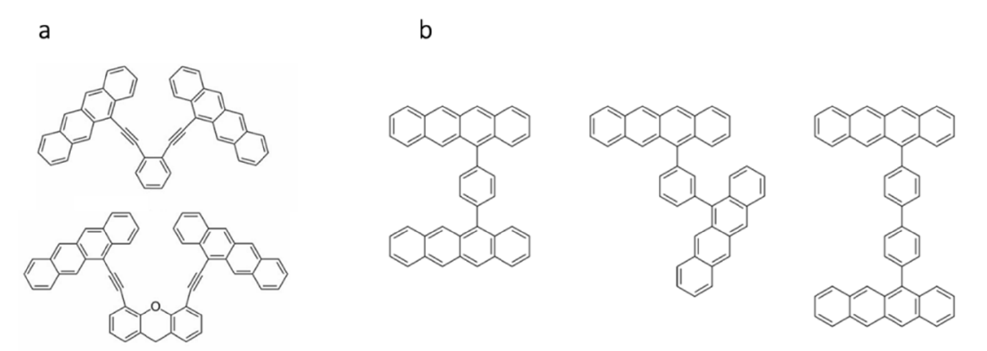
Figure 3. Staggered ( a ) and coplanar ( b ) configurations of tetracene moieties examined by A. Krylov et al. [46]. Reprinted with permission from [46], copyright 2016 Royal Society of Chemistry.